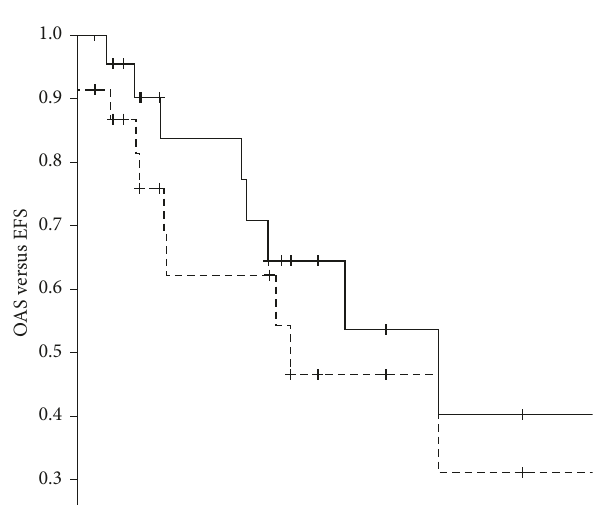
Figure 1: Overall survival ( ) (95% confidence interval: 0.0–10.8) and event-free survival ( ) (95% confidence interval: 3.6–14.3) of the 23 patients with high-grade osteosarcoma of the